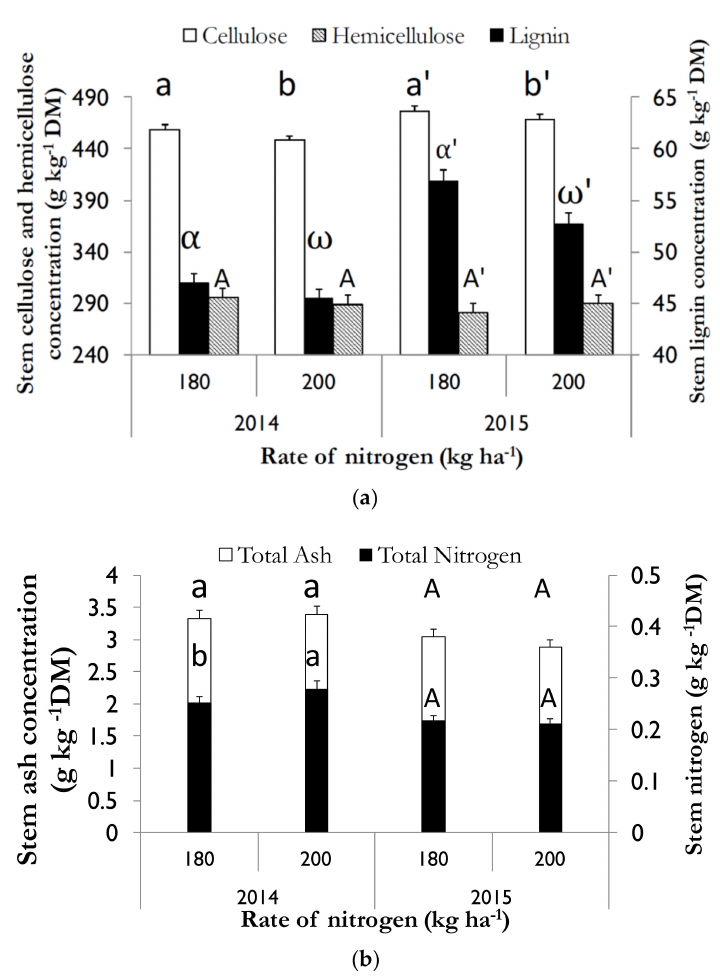
Figure 4. Nitrogen effect on feedstock composition for temperate and tropical maize. ( a ) Effect of nitrogen rate on stem cellulose (white bars), hemicellulose (gray bars), and lignin (gray bars) concentrations during two growing seasons across temperate and tropical maize grown in Boone County, IA. ( b ) Effect of nitrogen rate on stem ash (white bars) and nitrogen (black bars) concentrations across temperate and tropical maize grown in Boone County, IA. Treatments were determined within each year. Different letters on the top of standard error bars mean significant differences among treatments ( p >